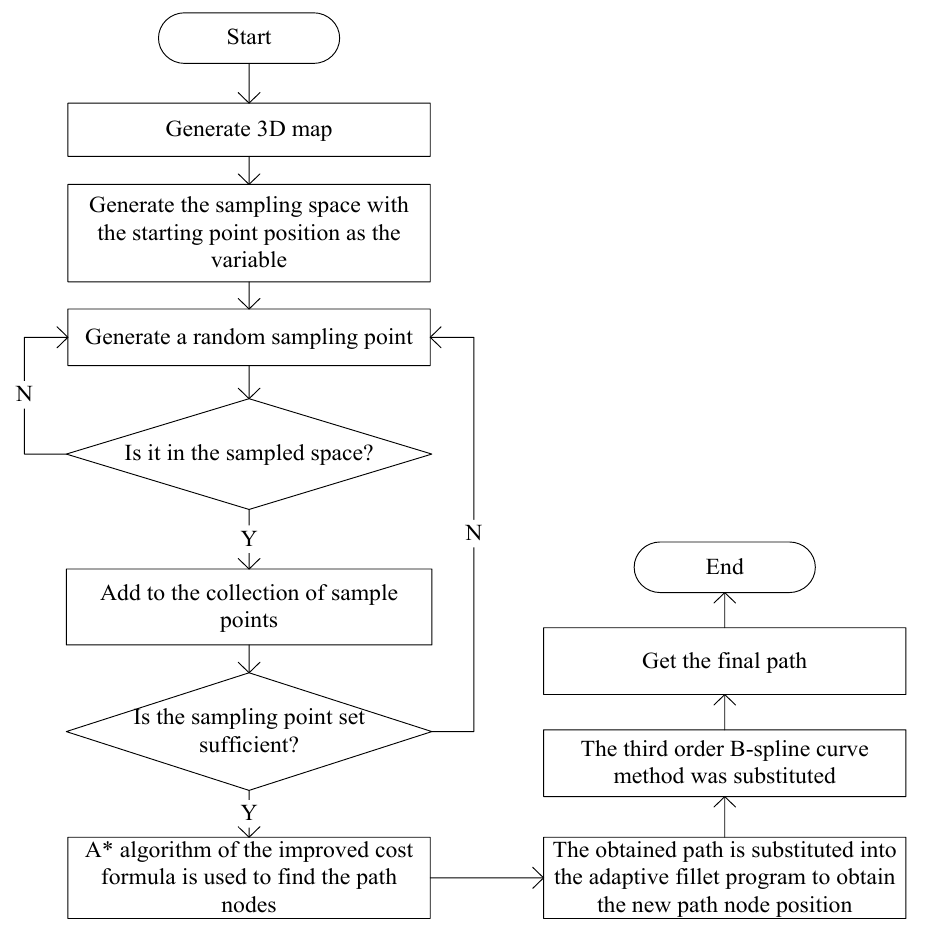
Figure 10. Flowchart of